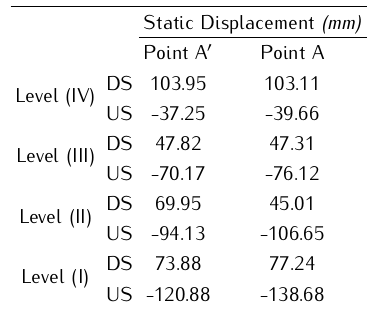
Figure 14. Time-history of US/DS displacement for crest central nodes; NL-DCM Table 5. Maximum displacement of the crest nodes in crown can- tilever in stream direction;